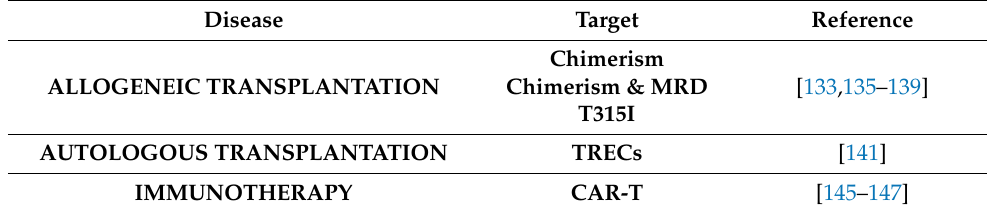
Table 3. ddPCR and